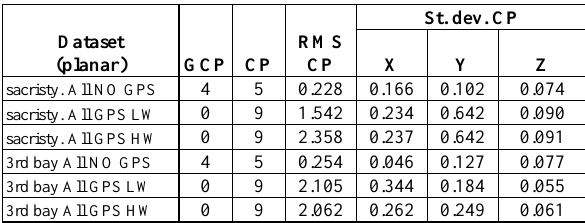
Table 10. Planar dataset: stats on residuals